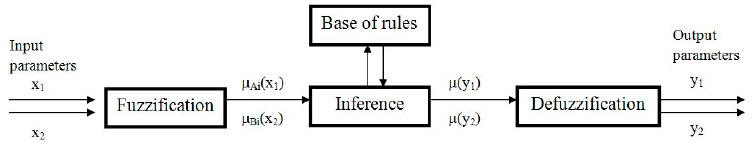
Figure 4. Classical structure of a fuzzy system. 217